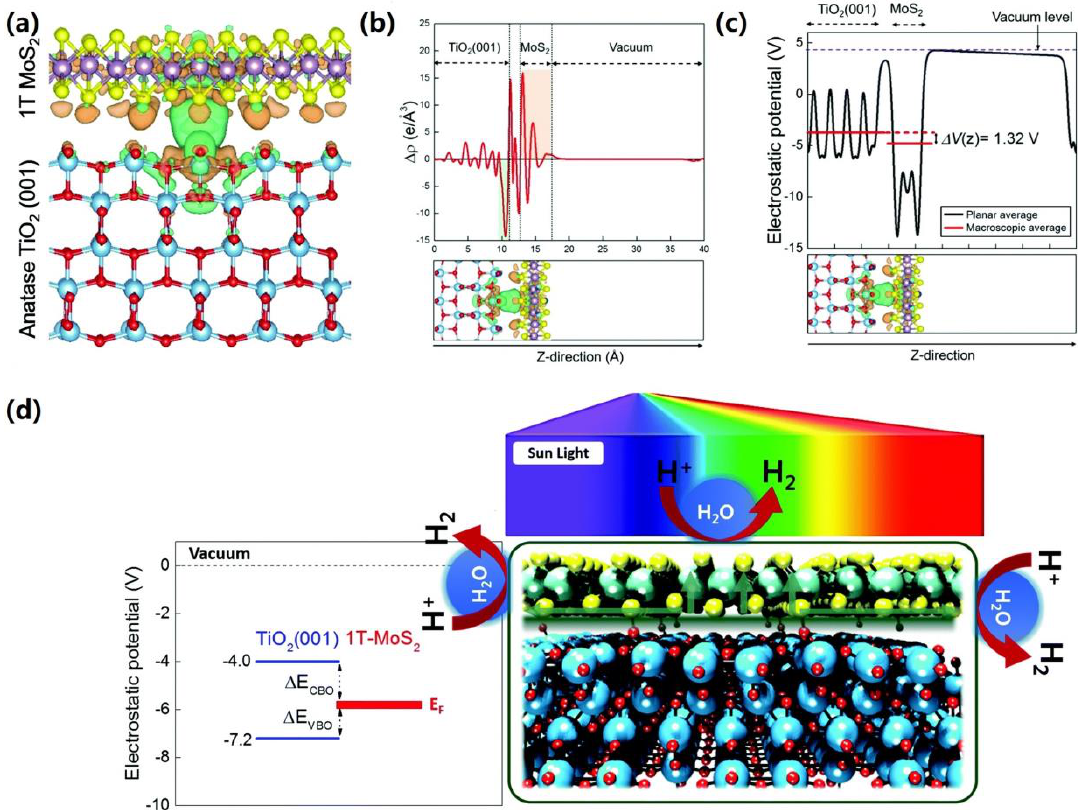
Figure 19. ( a ) The charge density difference, ( b ) electrostatic potential and differential charge density of the MoS 2 /TiO 2 (001) junction; ( c ) Planar-averaged differential electron density Dr(z) for MoS 2 /TiO 2 (001); ( d ) Photocatalytic mechanism for 1T-MoS 2 /TiO 2 . Reprinted with permission from [131]. Copyright 2017, the Owner Societies.